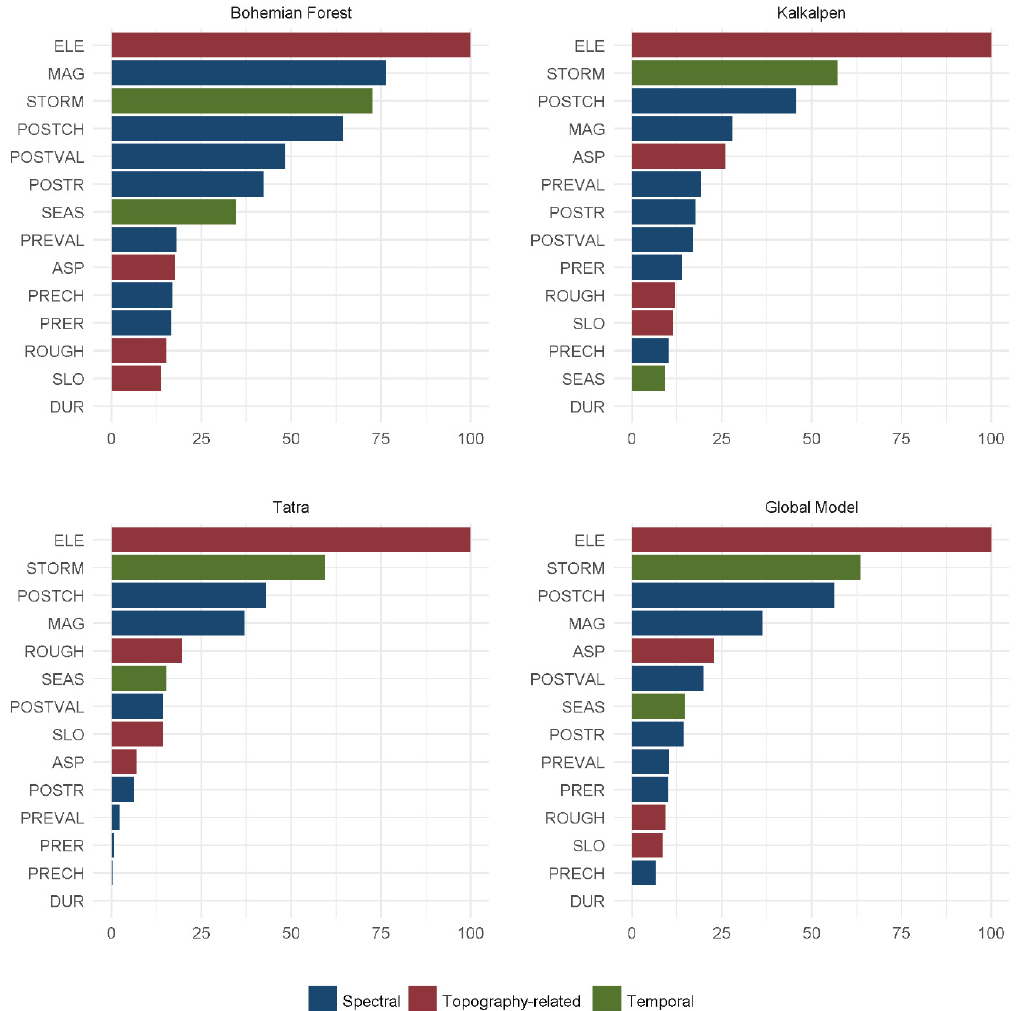
Figure 6. Relative variable importance for site ‐ specific models and the combined global model as normalized importance scores based on the Gini index. Colors represent different metric groups (spectral, topography ‐ related, temporal).